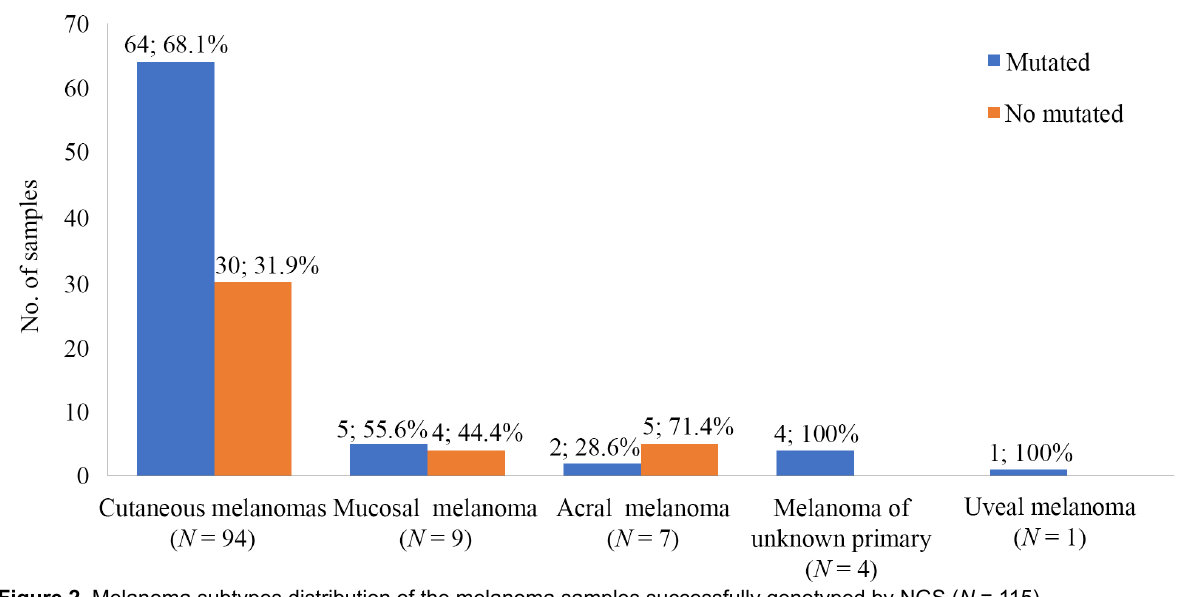
Figure 2. Melanoma subtypes distribution of the melanoma samples successfully genotyped by NGS ( N = 115)